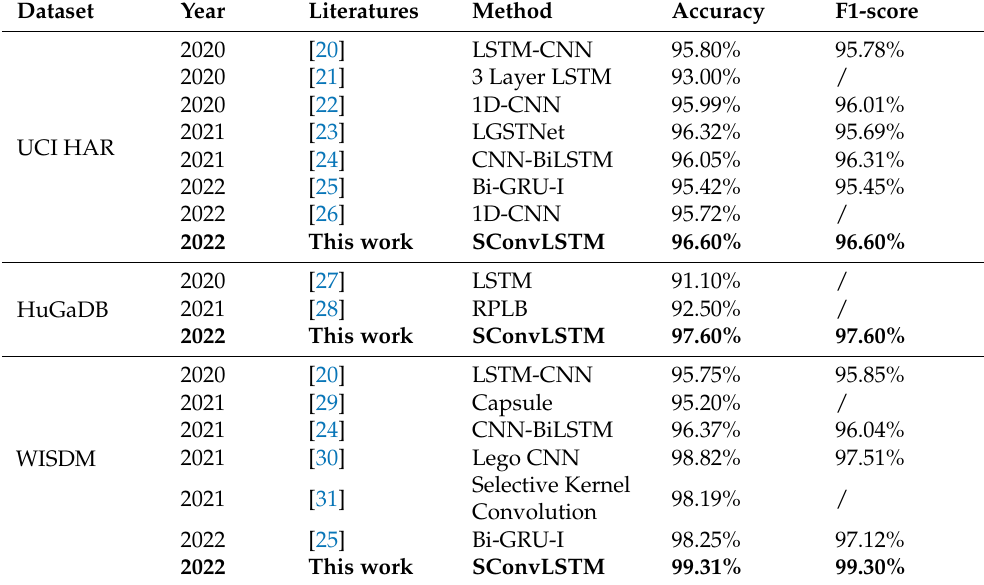
Table 6. Comparison of some state-of-the-art methods surveyed on UCI HAR, HuGaDB, and WISDM